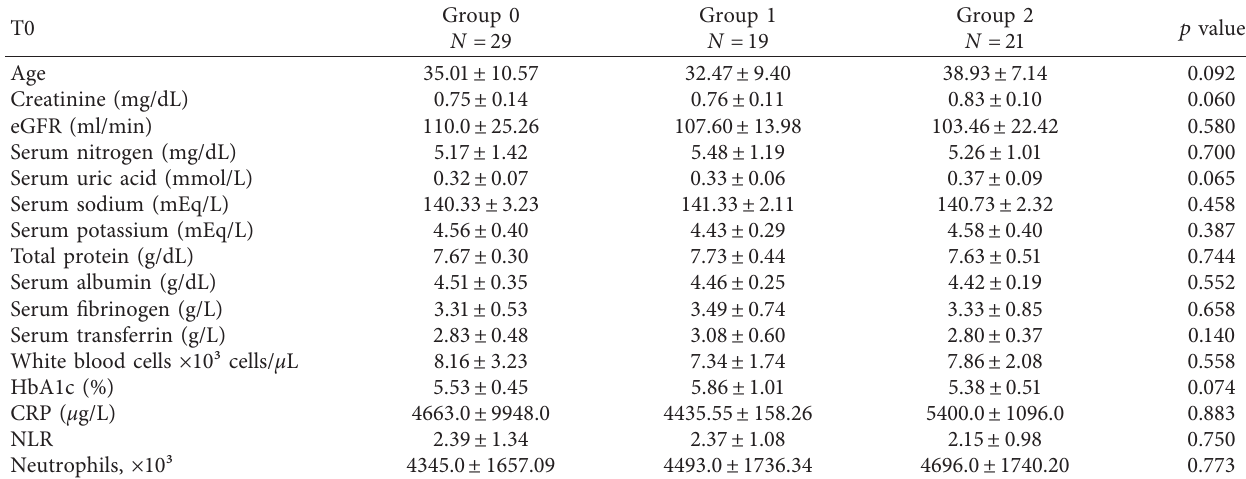
Table 1: Patients’ characteristics at T0.